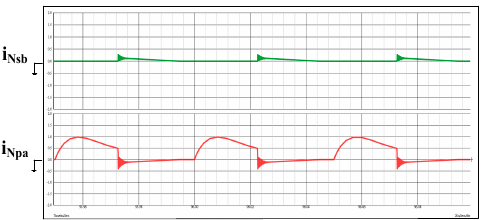
Figure 16. Simulation of current waveforms (i Nsb, i Npa ), i Nsb, i Npa : 500 mA/div, Time: 20 µs/div.